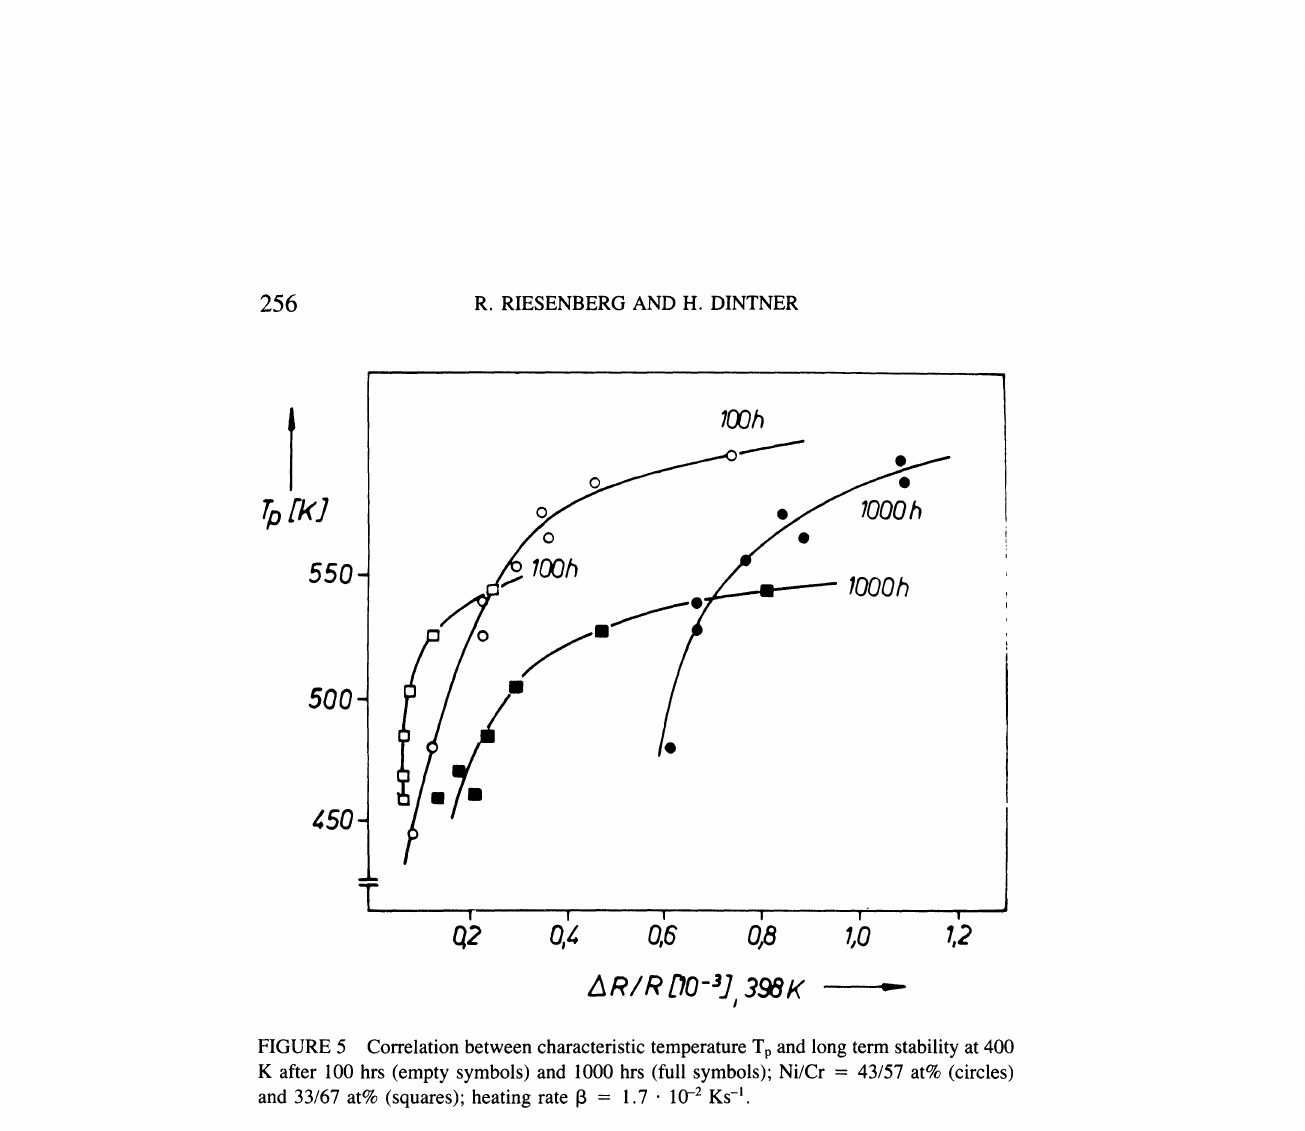
FIGURE 5 Correlation between characteristic temperature T and long term stability at 400 K after 100 hrs (empty symbols) and 1000 hrs (full symbols); Ni/Cr 43/57 at% (circles) and 33/67 at% (squares); heating rate 13 1.7 10 -2 Ks